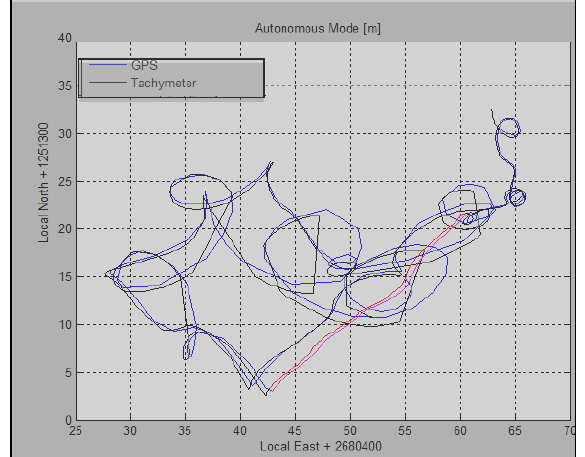
Figure 4: 2D-Plot of the registered trajectories. The analysis of one flight line is highlighted in red